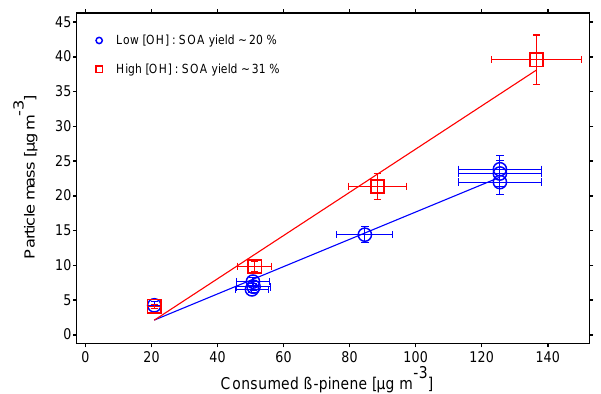
Figure 3. Total aerosol mass concentration as a function of the amount of reacted β -pinene under low-[OH] (blue open circles) and high-[OH] (red open squares) conditions. The SOA yield was esti- mated from the aerosol mass linear regression slope as a function of consumed β -pinene, which resulted in approximately 20 ± 1% and 31 ± 3% for low- and high-OH conditions respectively. The error in [consumed β -pinene] was estimated to be ± 10% and the error in particle mass was estimated from the sum of the systematic error and the correction procedure